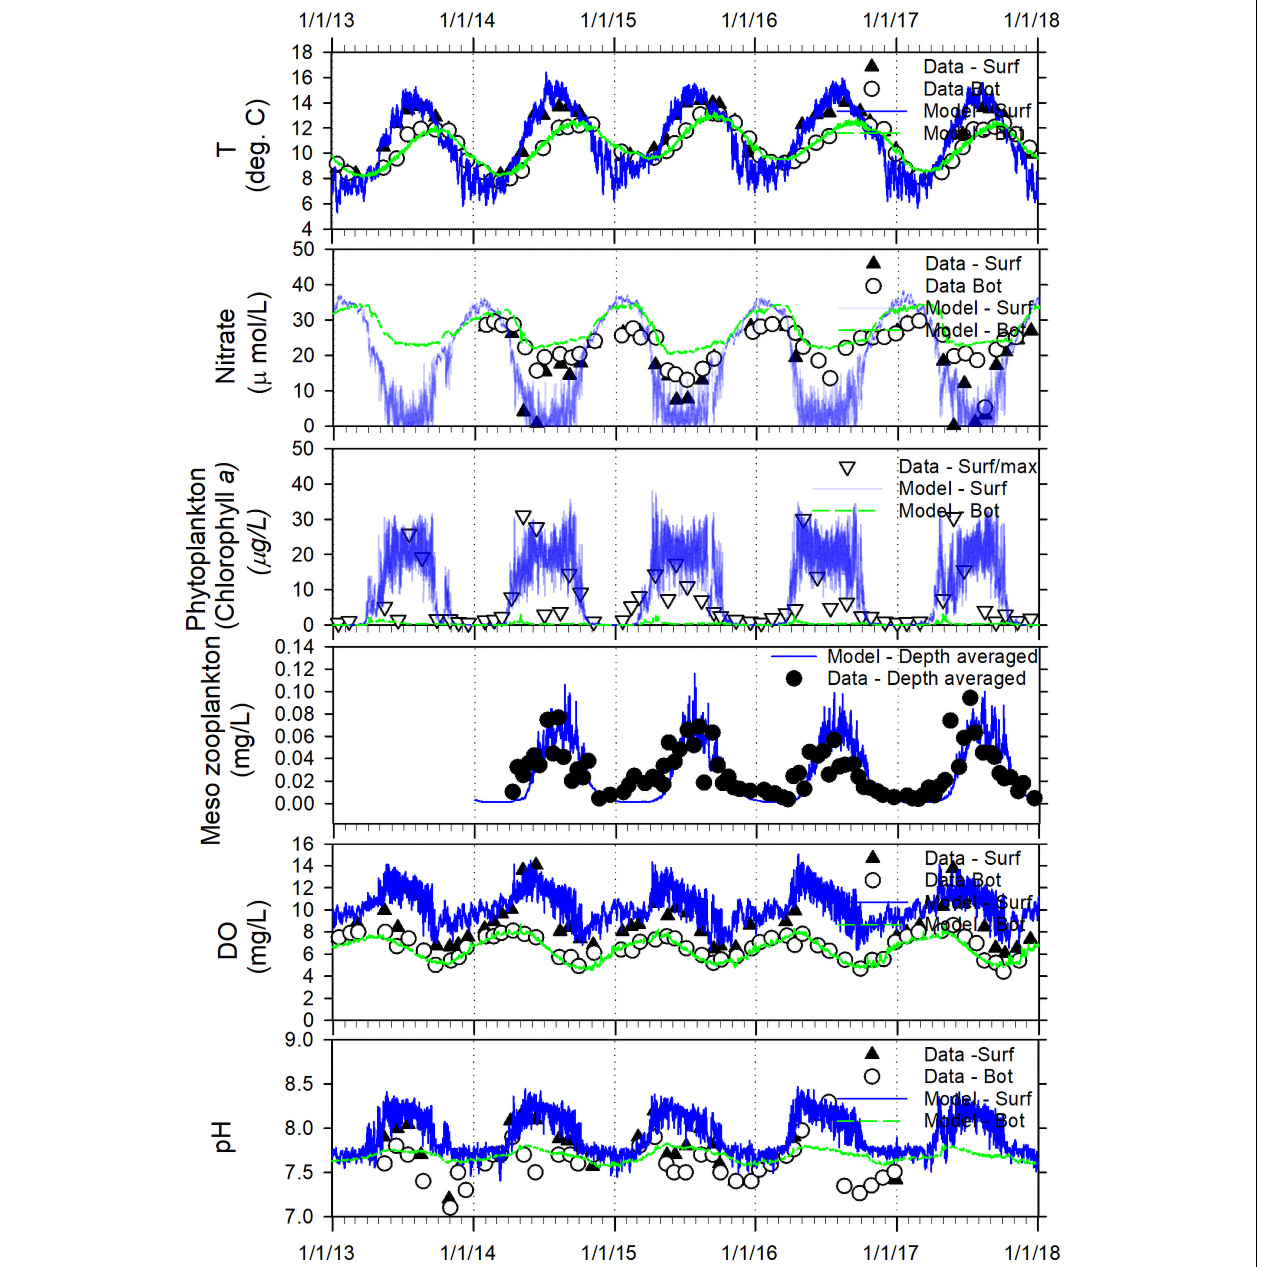
FIGURE 2 | Salish Sea Model validation: a time series comparison of model predictions and observed data for T, nitrate (NO 3 + NO 2 ), phytoplankton biomass as chlorophyll a , zooplankton biomass, DO, and pH from the surface (outflow) and bottom (inflow) layers from a representative station (Elliot Bay) in the Central Puget Sound region of the Salish Sea from 2013 through